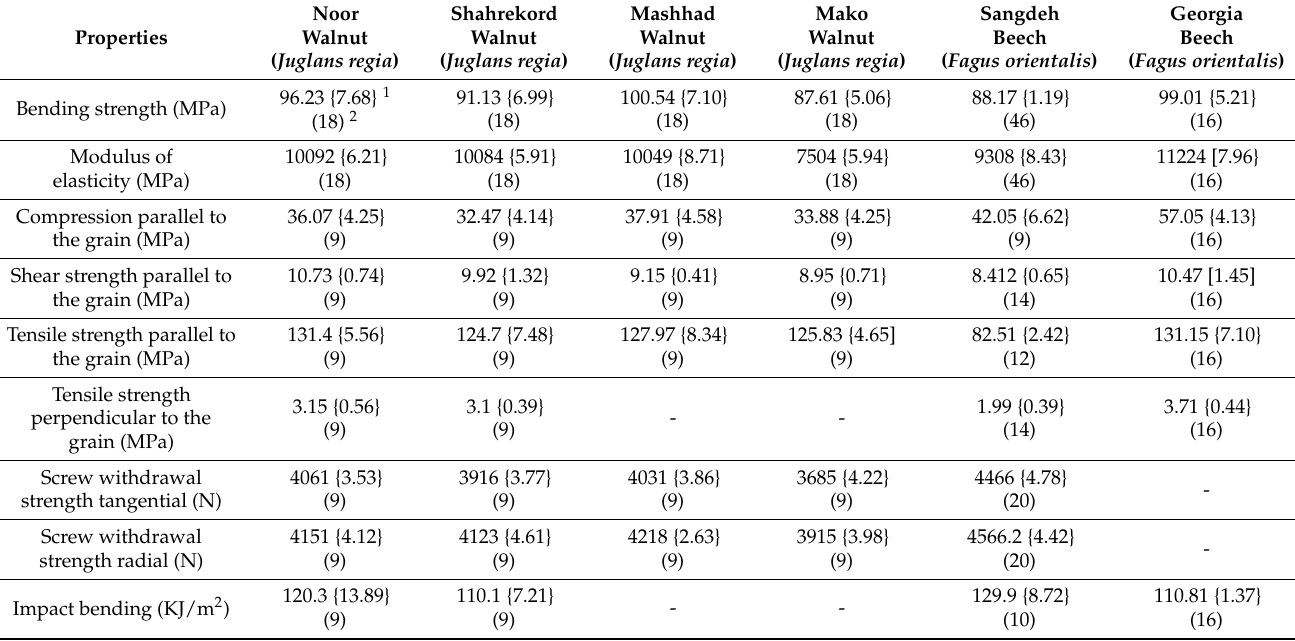
Table 5. Mechanical properties of the studied wood species.